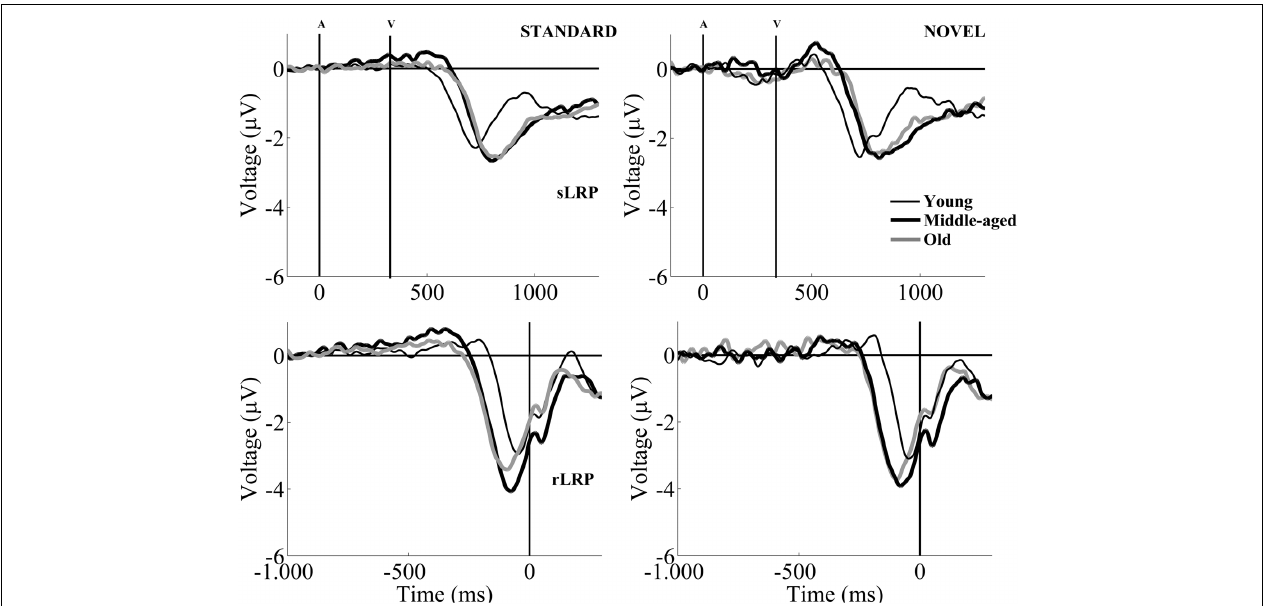
FIGURE 3 | Grand-average sLRP (upper figures) and rLRP waveforms (lower figures) for the Young (thin black line), Middle-aged (thick black line), and Old (thick gray line) groups, in the standard (left) and the novel (right) conditions. In order to obtain the sLRP and rLRP waveforms,